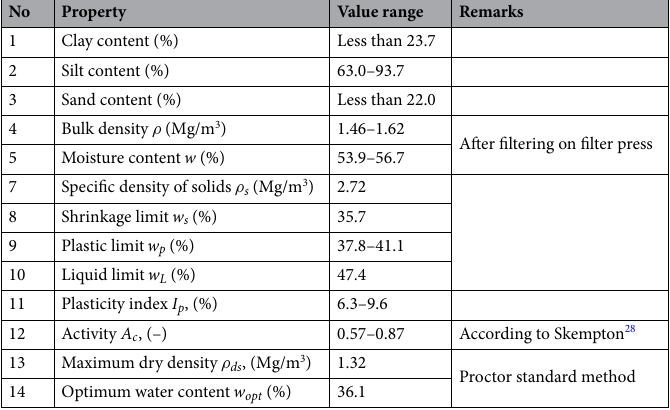
Table 2. Geotechnical properties of lime-softening sludge 9 .